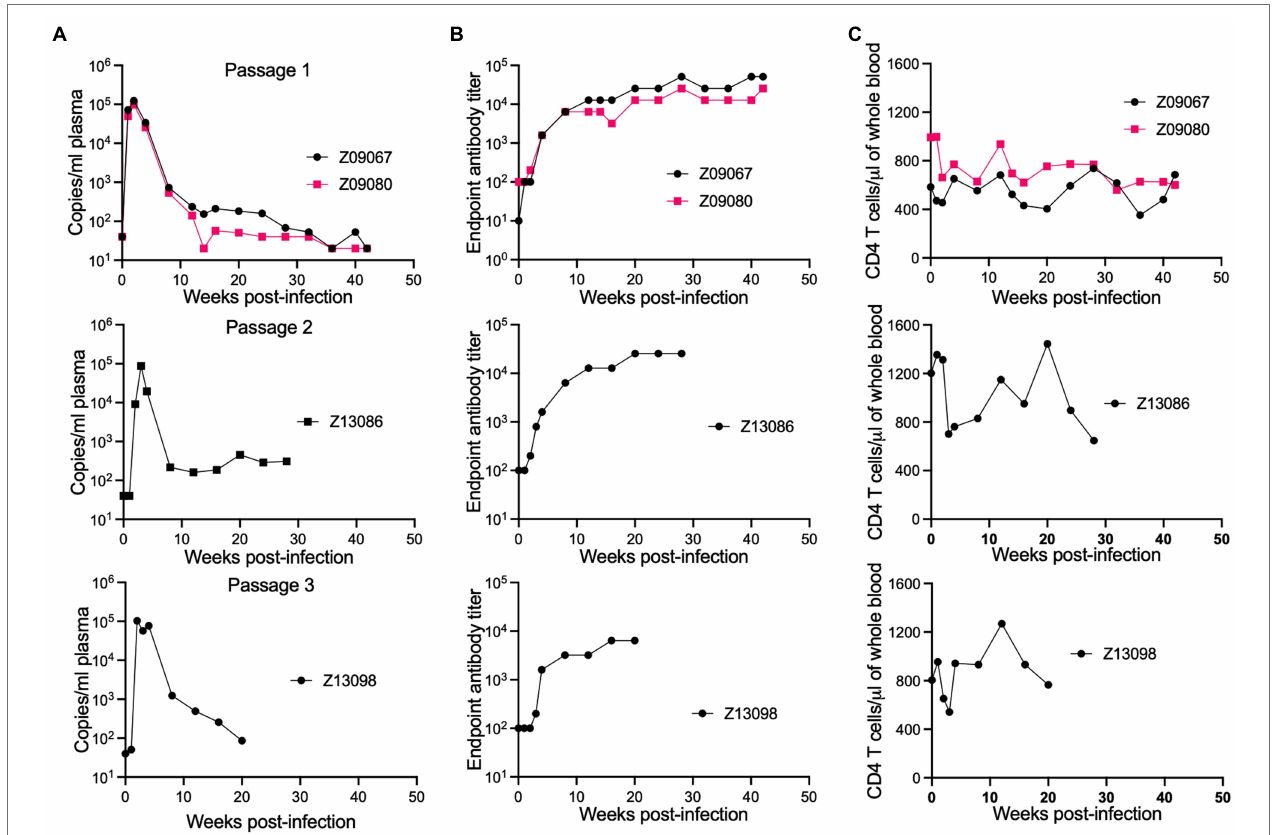
FIGURE 6 | Passaging of HSIV to generate pathogenic variants. Passage 1 macaques were infected with a mixture of viruses. At 14 wpi, pooled blood from infected PTMs (Z09080 and Z09067) was used to inoculate a naïve macaque (Z13086) and then blood from Z13086 at 8 wpi was passaged through an additional PTM (Z13098). At several time points post-inoculation, peripheral blood was drawn for measuring plasma viral loads (A) , antibody titer (B) , and CD4 T cell counts (C)